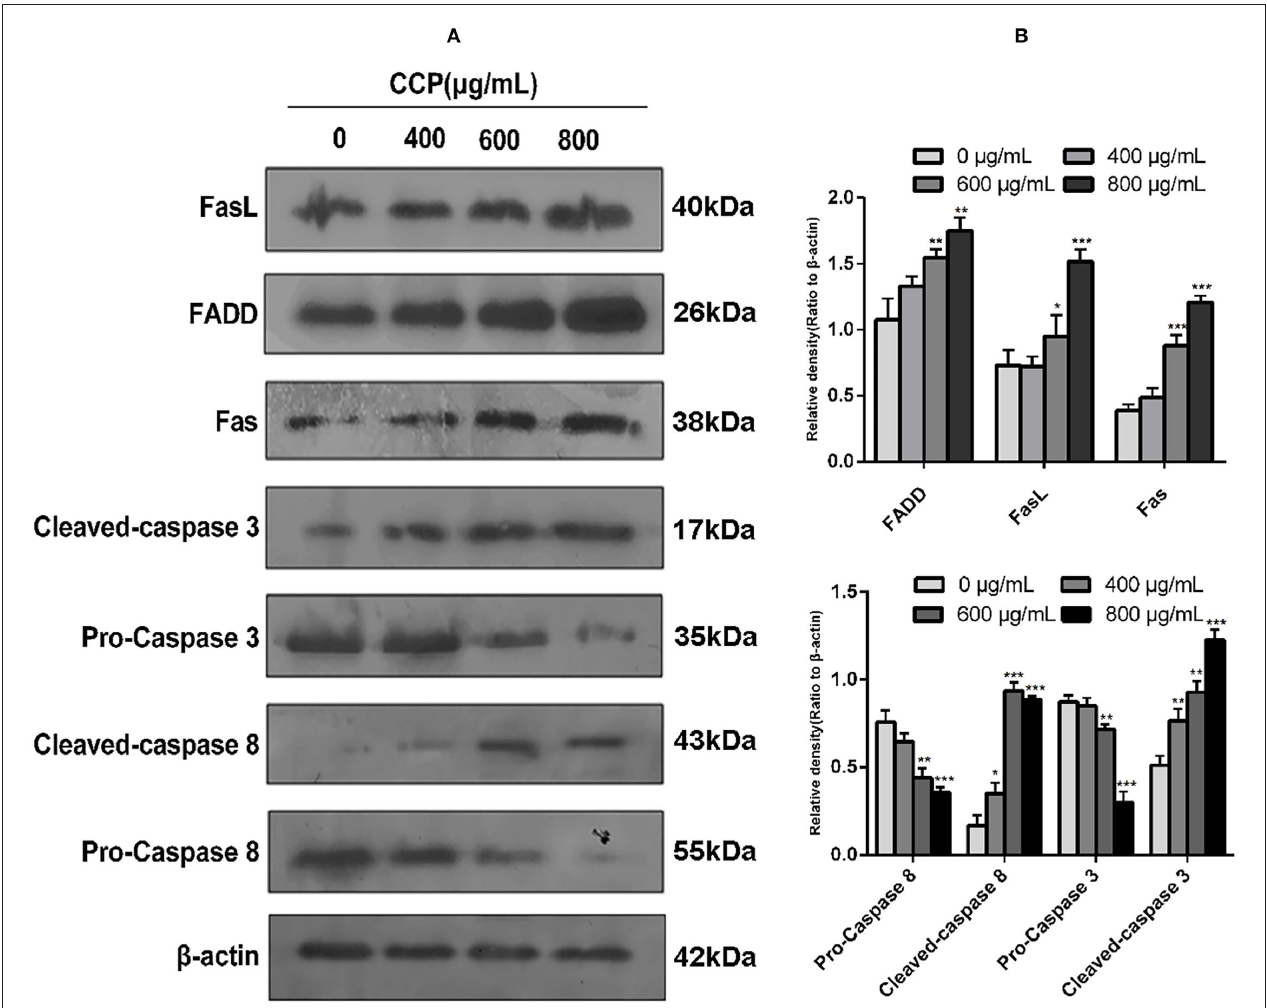
FIGURE 7 | (A) Western blot assay for FasL, FADD, Fas, caspase-3, cleaved-caspase-3, caspase-8 and cleaved-caspase-8 protein expression levels. (B) Columns represent the expression of the FasL, FADD, Fas, caspase-3, cleaved-caspase-3, caspase-8 and cleaved-caspase-8 relative to β -actin. * P < 0.05, ** P < 0.01 and *** P < 0.001 vs. control